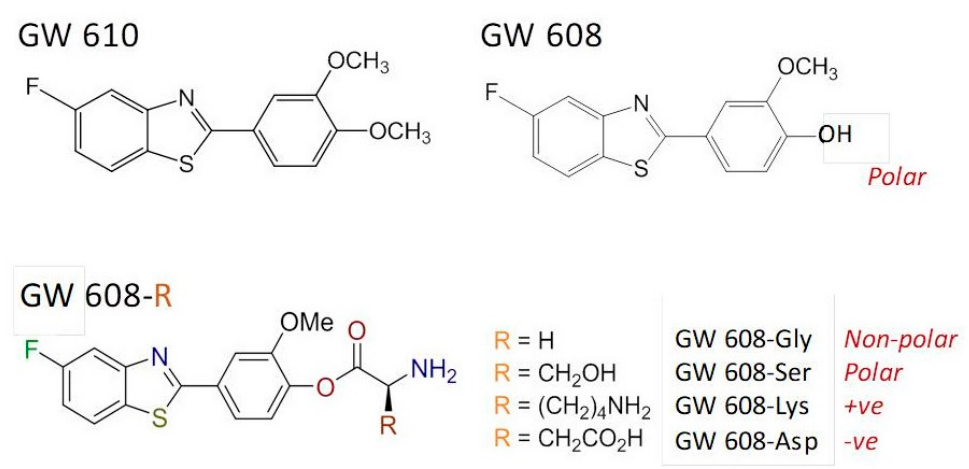
Figure 7. Chemical structures of the GW 610, GW 608 and amino acid prodrugs.